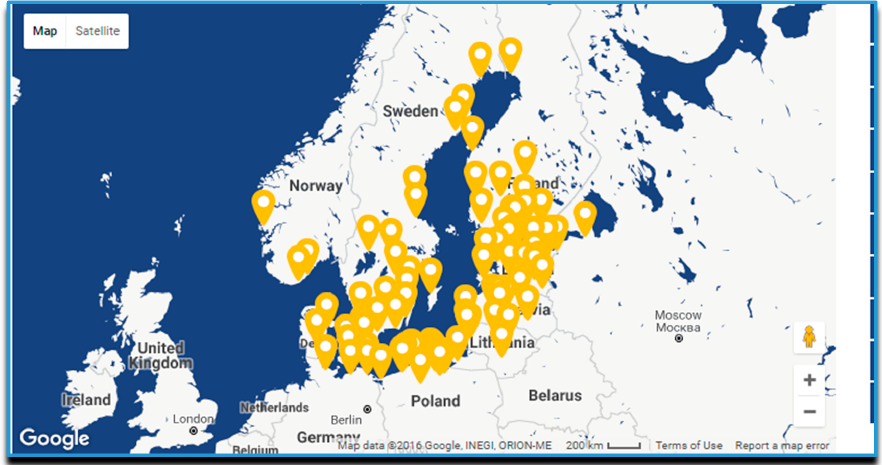
Figure 3. Map showing the member cities of the Union of Baltic Cities [41].